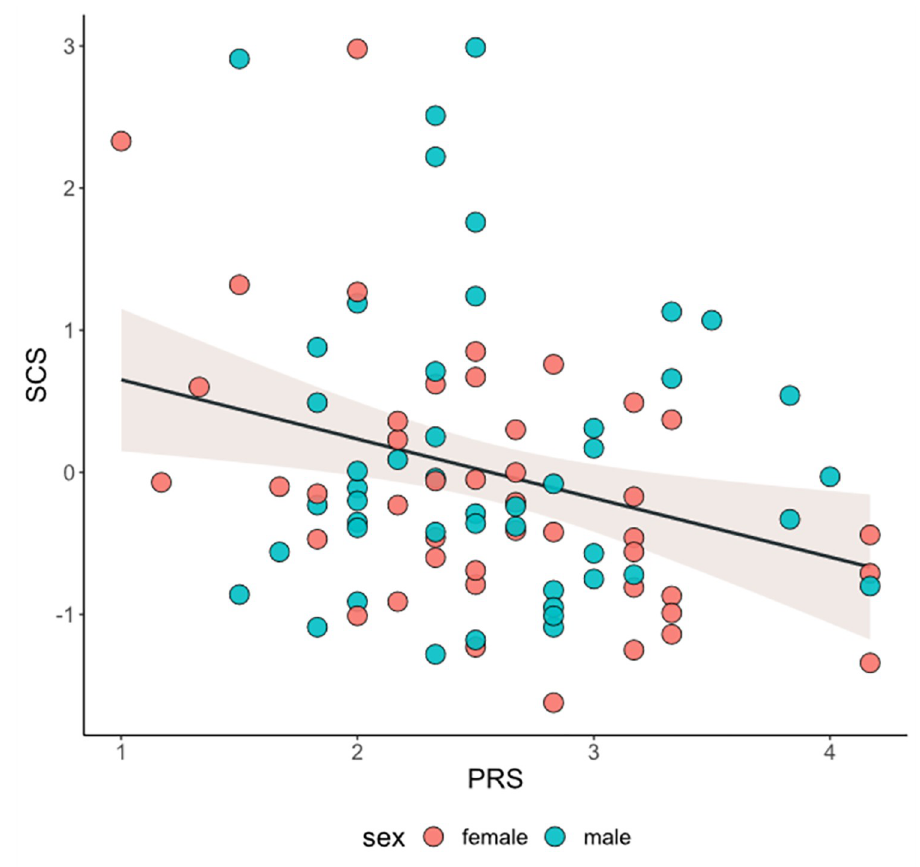
Fig 5. Linear association between maternal pandemic-related stress (PRS) during pregnancy and infants’ over- arching socio-cognitive score (SCS) at 12-month-age. Note. Infant SCS scores are standardized (mean = 0, sd = 1). Standardized estimate for PRS = -0.28, p =